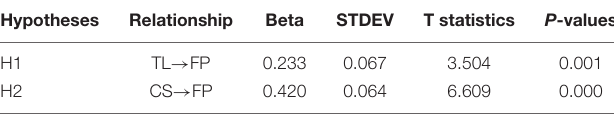
TABLE 8 | Goodness-of-fit index